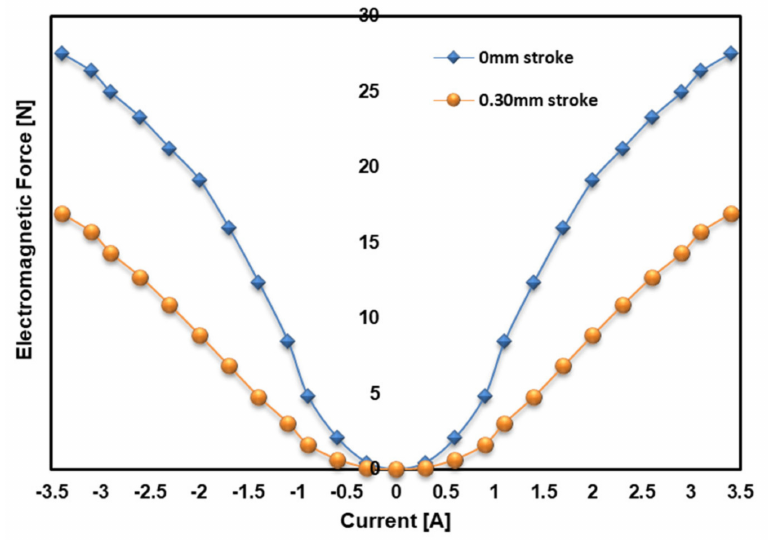
Figure 13. Electromagnetic force for each stroke in the conventional